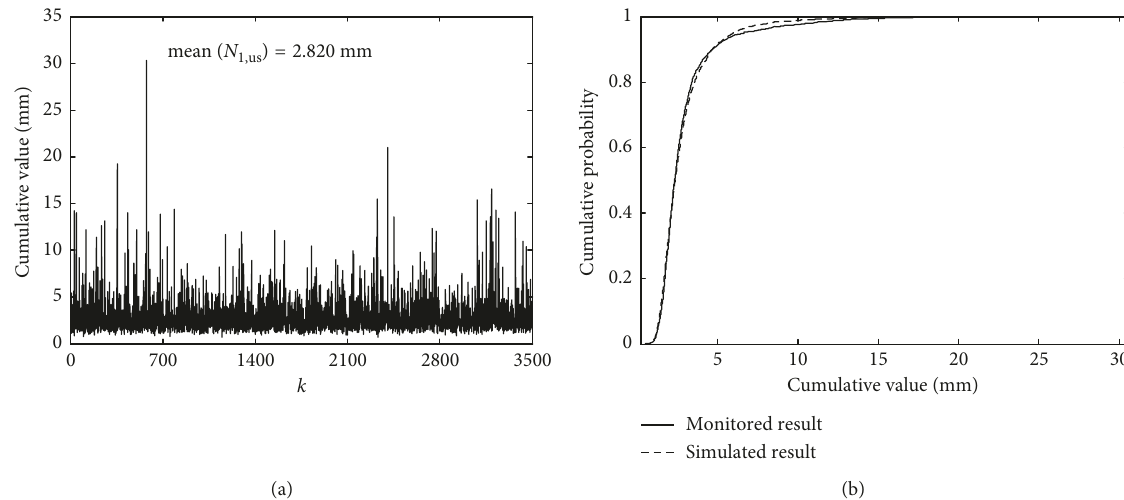
Figure 11: The simulated N and its CP. (a) The simulated result. (b) A comparison between the simulated and monitored 1 , us